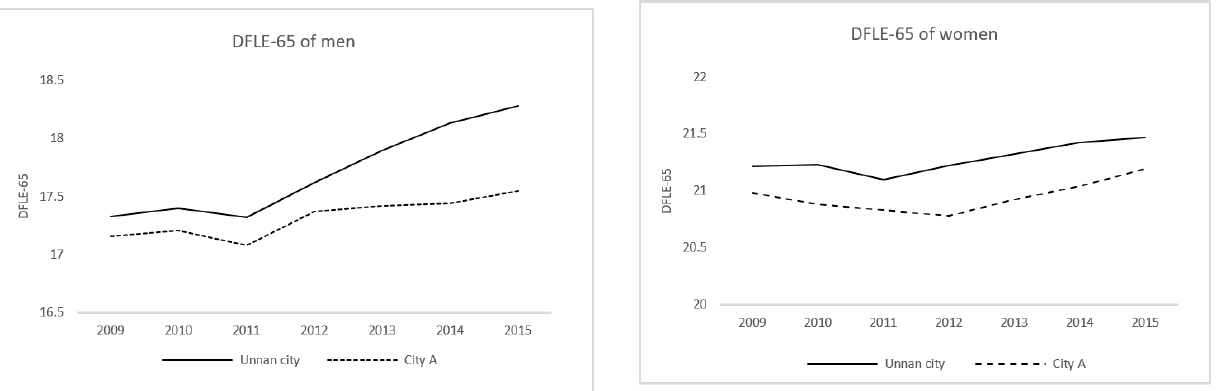
Figure 2. Changes in DFLE-65 for Unnan City and City A.